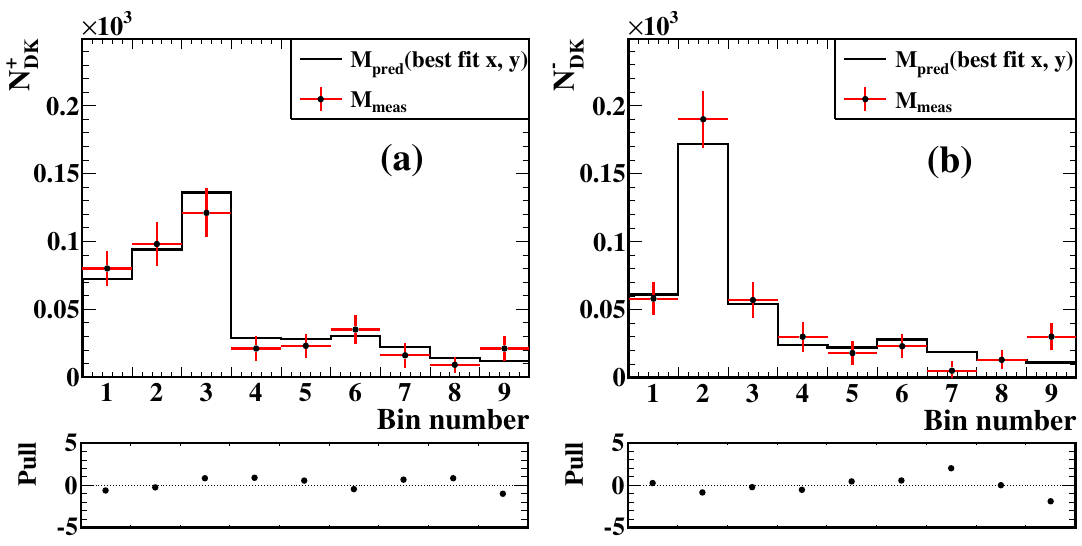
Figure 8 . Measured and expected yields in bins for (a) B + ! DK + and (b) B (cid:0) ! DK (cid:0) data samples. The data points with error bars are the measured yields, and the solid histogram is the expected yield from the best (cid:12)t ( x (cid:6) ; y (cid:6) ) parameter